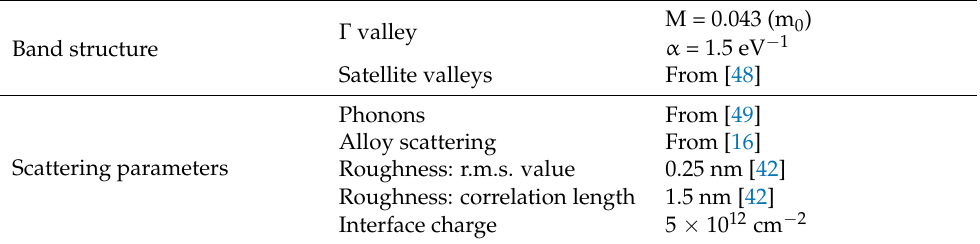
Table 2. Main model parameters of the MV–MSMC.